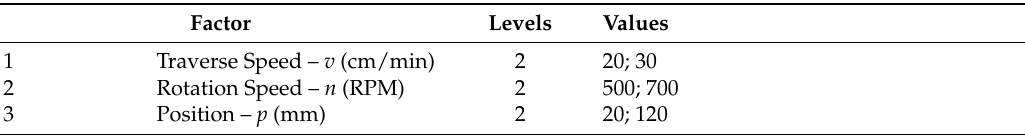
Table 6. General Linear Model: UTS versus traverse speed, rotation speed, and position of samples along the welding